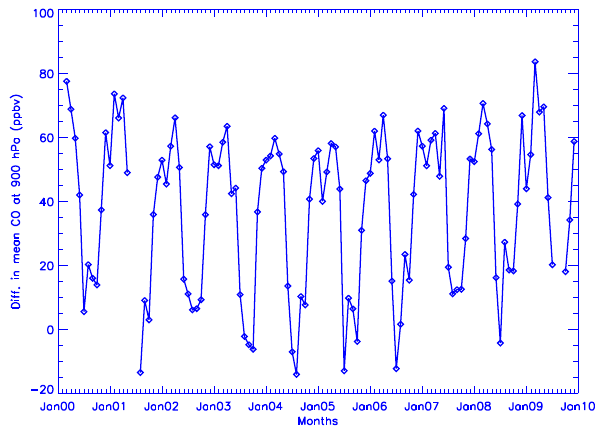
Fig. 5. Time series of the difference in mean CO at 900hPa be- tween the Eastern IGP (20 ◦ N–27 ◦ N, 80 ◦ E–90 ◦ E) and Western India (20 ◦ N–27 ◦ N, 65 ◦ E–80 ◦ E).